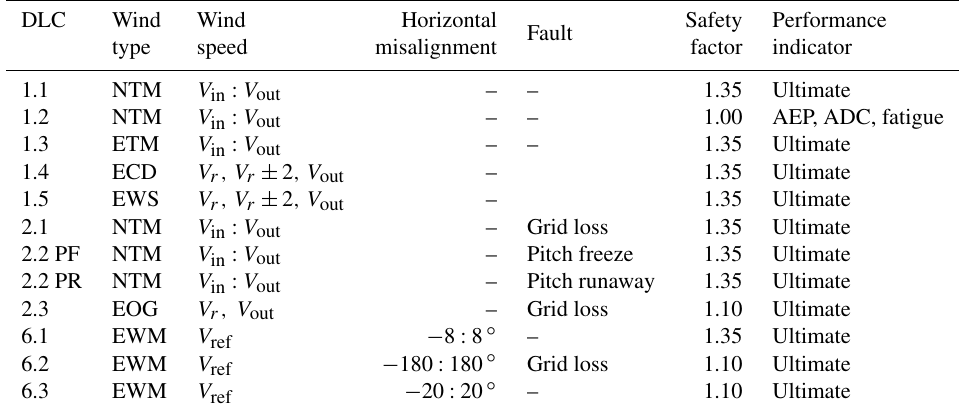
Table 1. Definition of the DLCs considered in the analyses. NTM: normal turbulence model; ETM: extreme turbulence model; ECD: extreme coherent gust with direction change; EWS: extreme wind shear; EOG: extreme operating gust; EWM: extreme wind speed model. DLC Wind Wind Horizontal